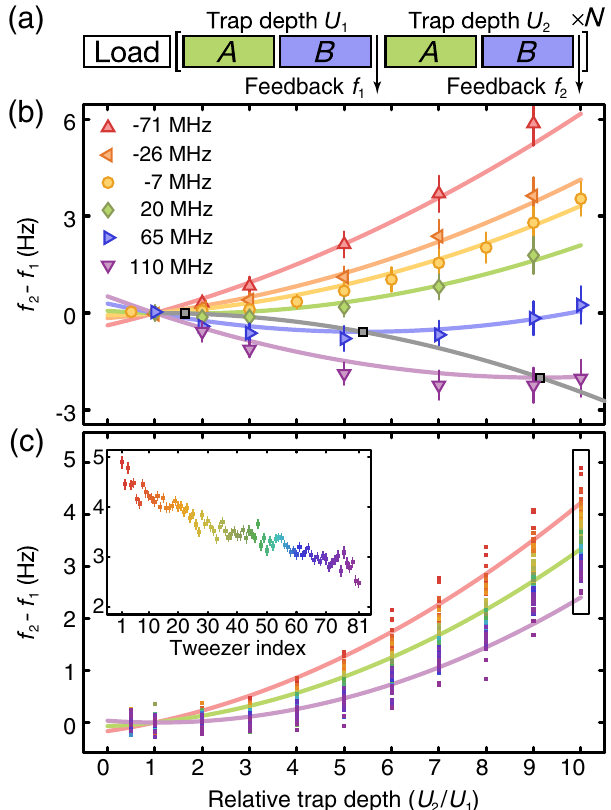
FIG. 3. Systematic evaluation of clock shifts with tweezer depth and wavelength. (a) Illustration of interleaved self-comparison, where two independent AOM frequencies ( f 1 and f 2 ) are updated in an alternating fashion. Respective interrogation blocks are set to two independent tweezer depths U 1 and U 2 . (b) Average frequency difference f 2 − f 1 as a function of U 2 =U 1 , with U 1 fixed to our usual interrogation depth, for multiple frequency offsets of the trapping laser (see legend for color coding). We fit the data with a model for light shifts in optical tweezers (colored lines) with only a single free parameter (for all data simulta- neously), accounting for an unknown frequency offset (Appen- dix E). Operational magic intensities are found at the minima of these curves (gray squares and connecting line), which minimize the sensitivity to trap-depth fluctuations. The trap laser frequency is tuned such that the minimum coincides with our nominal depth. (c) Combining this technique with the single-tweezer- resolved error h e , we can extract a frequency dependence with j i trap depth for each tweezer (colored squares). Solid lines show the expected dependence for the outermost and central tweezers. The data correspond to the − 7 MHz set in (b). Inset: Local frequency shifts for U 2 =U 1 ¼ 10 . The color coding of the inset defines the color coding of its subfigure.